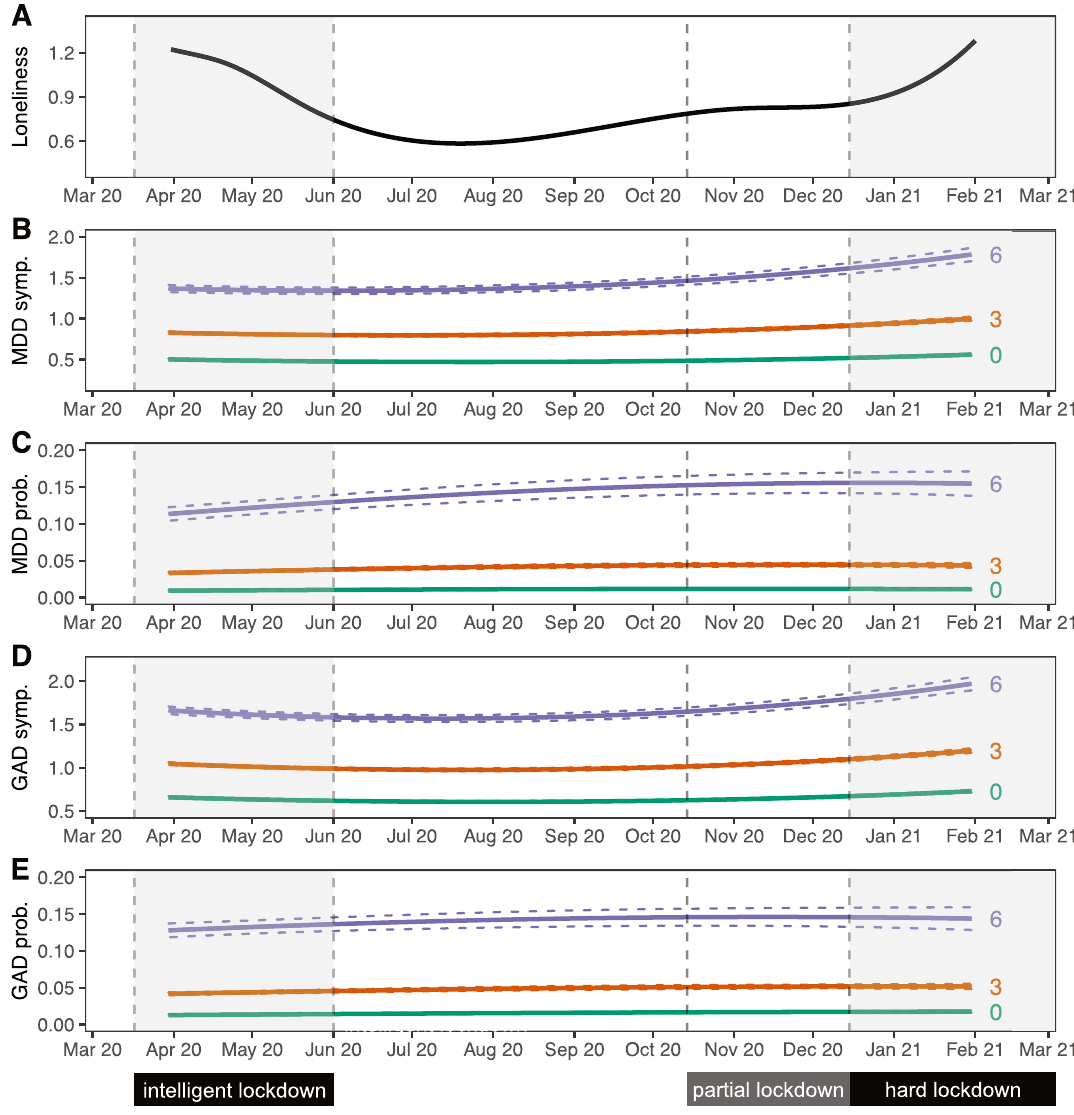
Figure 1. Trajectories of loneliness and MDD and GAD outcomes over time. Shaded areas represent periods during which lockdown measures were enforced in the Netherlands. The first ’intelligent’ lockdown consisted of restrictions such as social distancing and bans on public gatherings. During the partial lockdown, some restrictions were reintroduced. The ’hard’ lockdown introduced more restrictions and a curfew. ( A ) Marginal GEE effect plot of a GEE model of loneliness scores predicted by a polynomial spline time term. The 95% confidence interval of model-predicted values is not visible because the interval is very small. ( B – E ) Marginal GEE effect plot of predicted counts of MDD symptoms ( B ), odds of MDD diagnoses ( C ), counts of GAD symptoms ( D ) and odds of GAD diagnoses ( E ) across different levels (0/green; lowest, 3/orange; moderate, 6/ purple; highest) of loneliness scores. Predicted values represent symptoms counts and diagnosis probabilities, and are based on main model fits (Tables 2 and 3). Dashed lines represent a 95% confidence interval of model- predicted